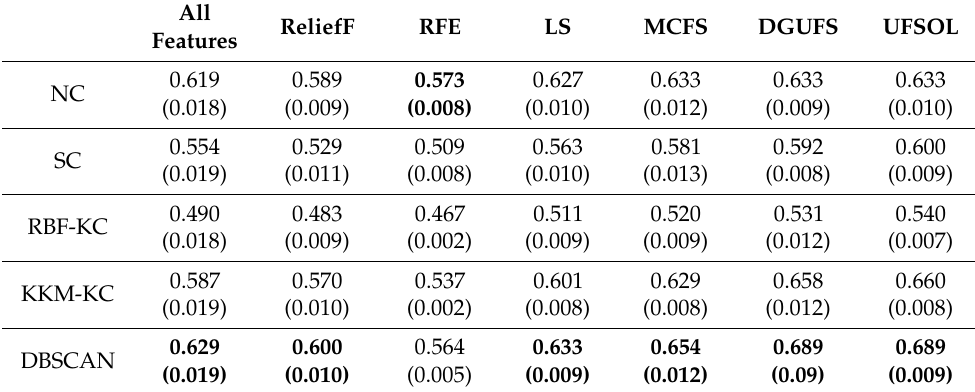
Table 5. Precision of clustering algorithms with different feature selection methods.